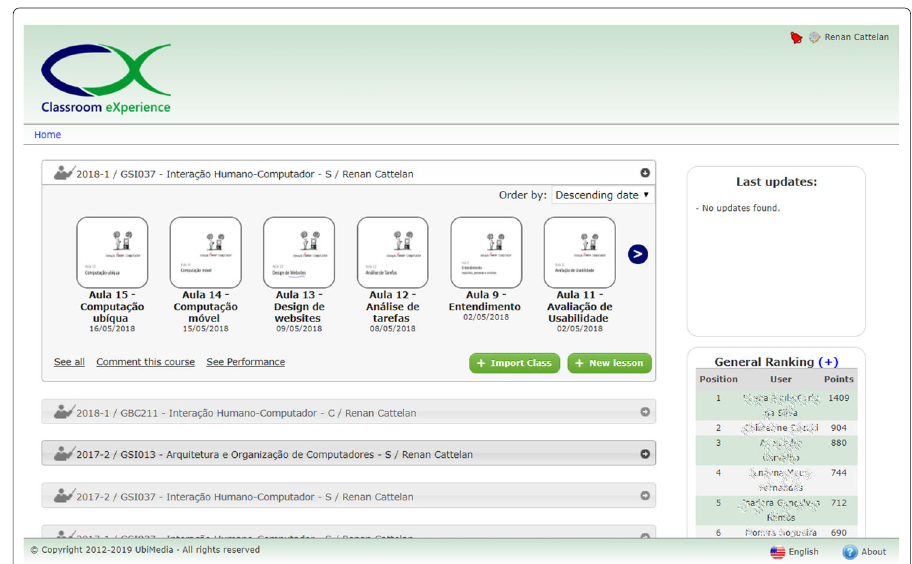
Fig. 1 CX access interface. List of courses and captured lectures in the CX Web access interface